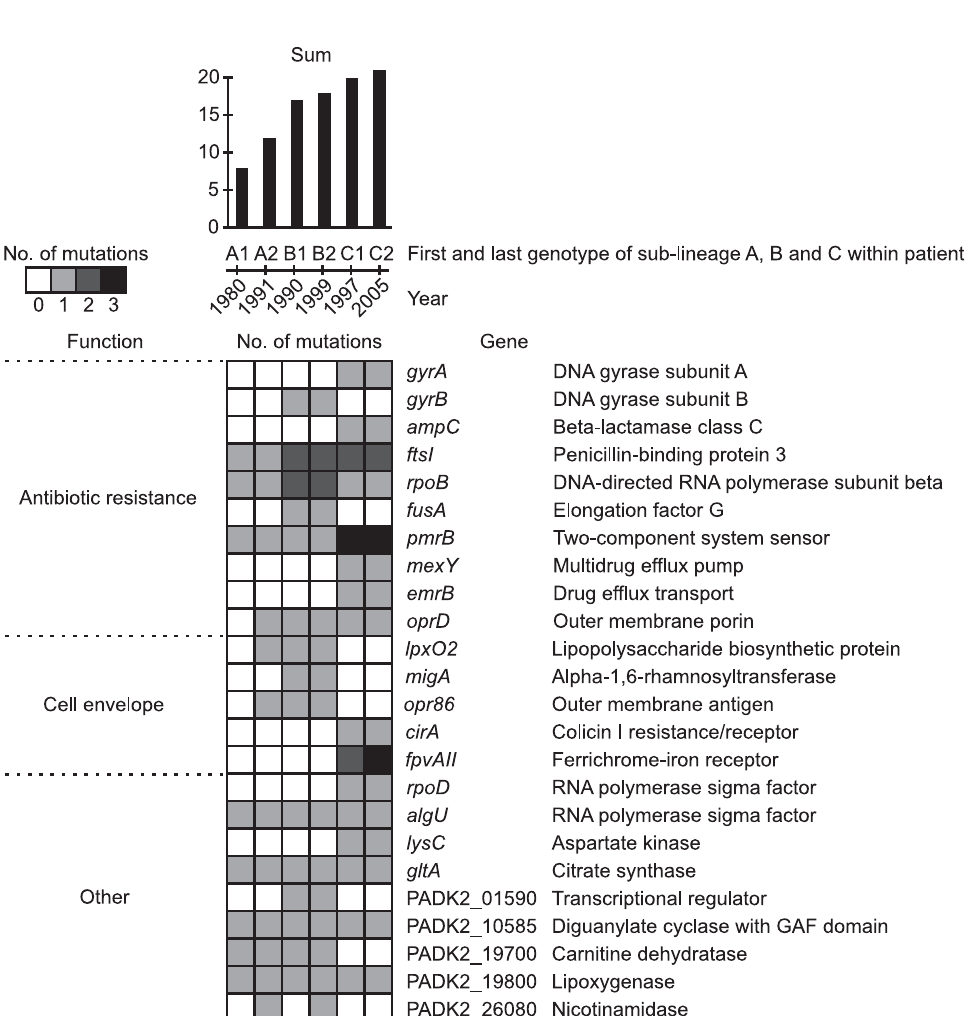
Figure 7. Pathoadaptive genes. Genes identified from parallel evolution to be involved in host adaptation. Colors of squares denotes if the gene was mutated relative to the MRCA of the DK2 clones. Only genes mutated in any of the isolates from CF173 are shown (see full list of pathoadaptive genes in Table S2). The presence of mutations is shown for the first and last genotypes of each of the DK2 sub-lineages A, B, and C, which were observed to have infected patient CF173. The total sum of mutations observed within each of the genotypes is indicated at the top. Genes are grouped by function. Details about specific mutations and their fixation in the DK2 isolates are given in Table S5, Table S6, and Figure S4.